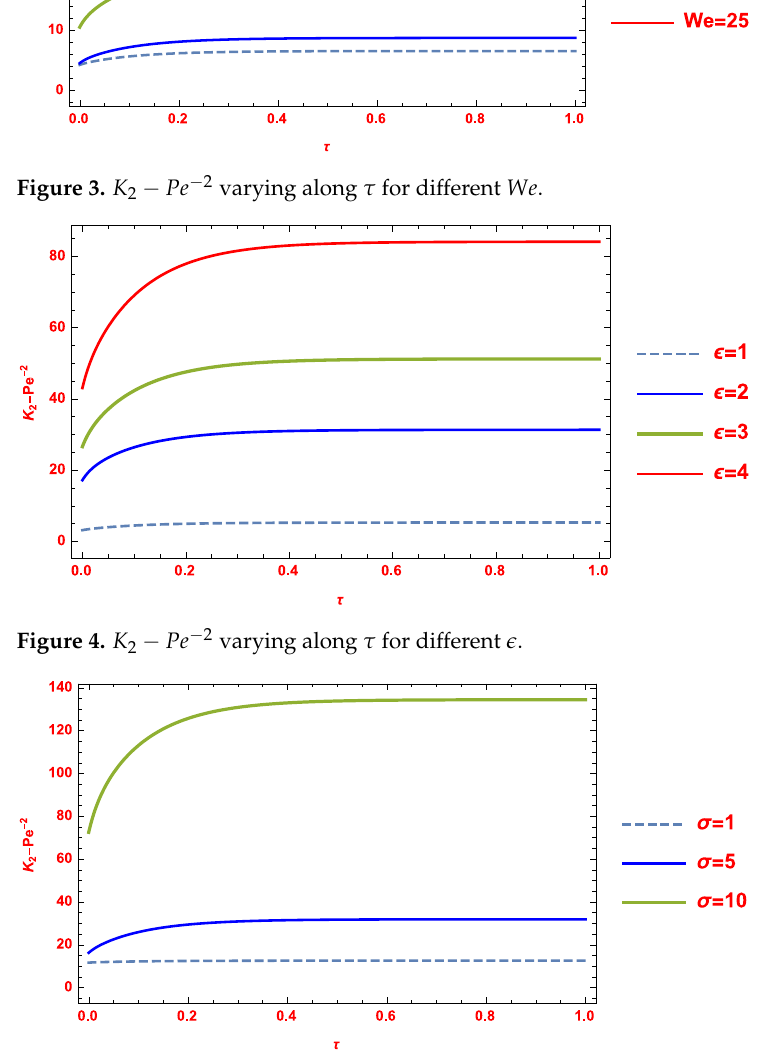
Figure 5. K 2 − Pe − 2 varying along τ for different σ